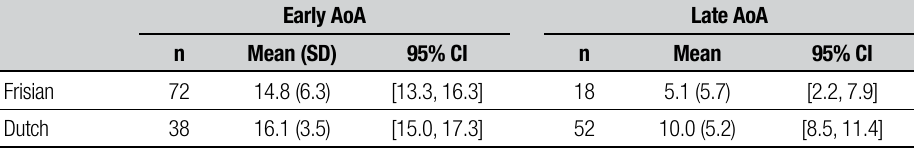
Table 2. Correct responses separated according to AoA.